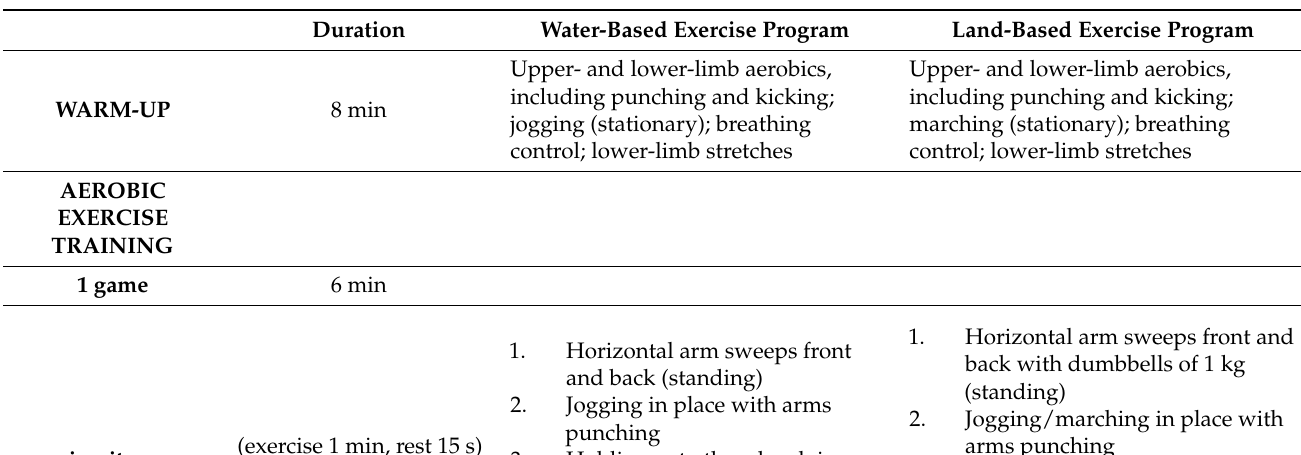
Table 2. Water-based and land-based exercises